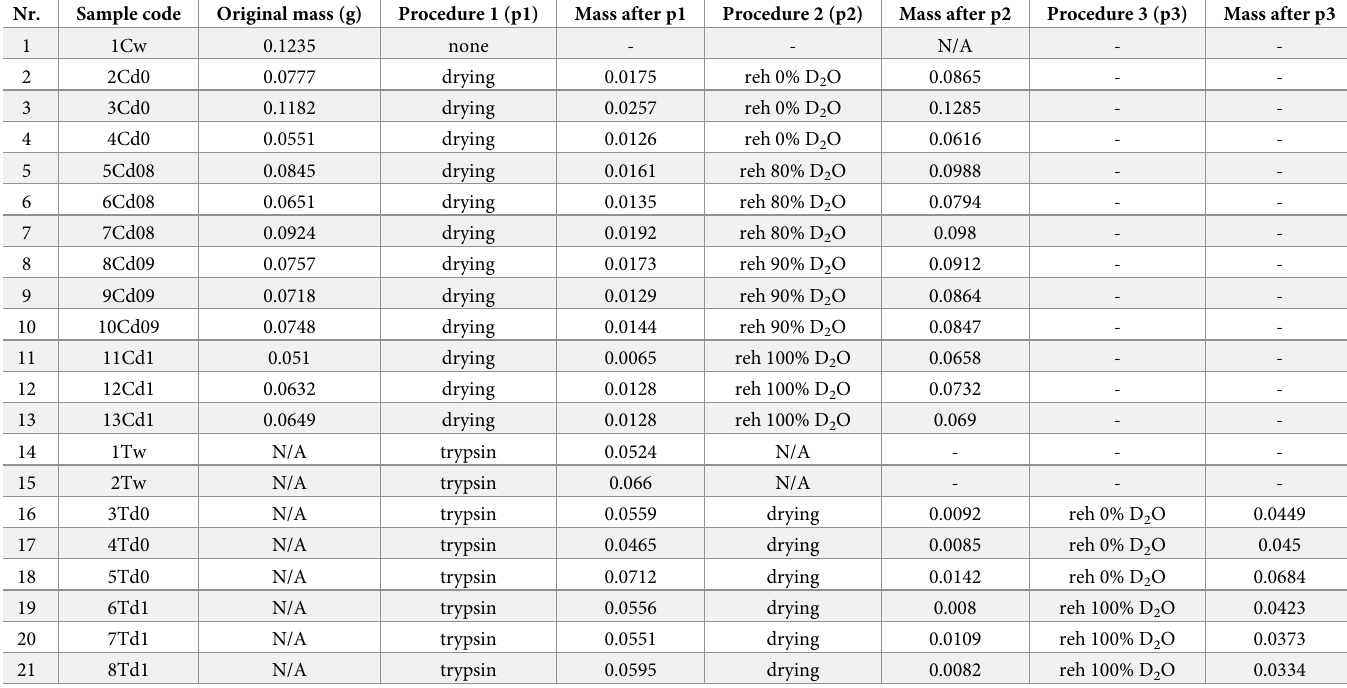
Table 1. Sample labels, procedures and weights for each sample (reh = rehydrated with PBS solution). Nr. Sample